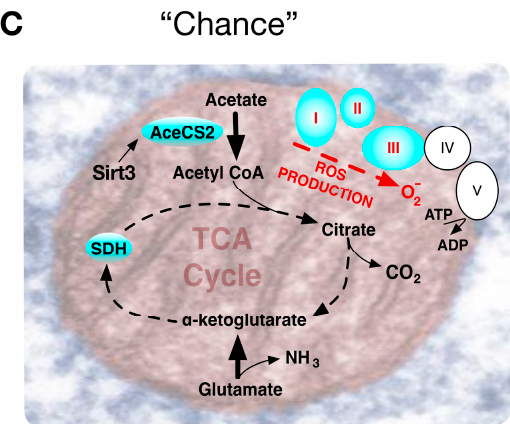
Figure 4. Mechanisms influencing the mitochondrial metabolism and the Warburg